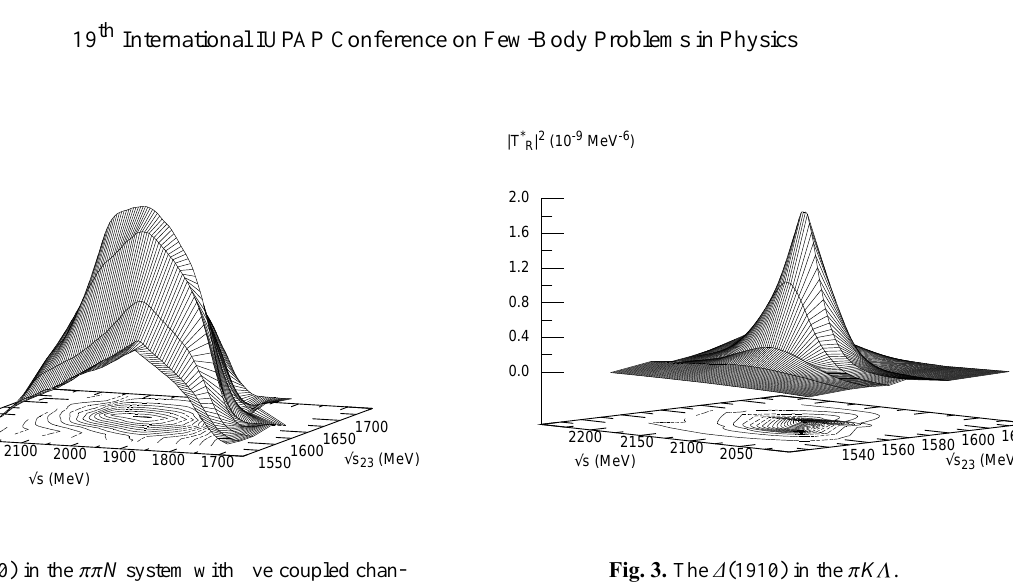
Fig. 3. The ∆ (1910) in the π K Λ